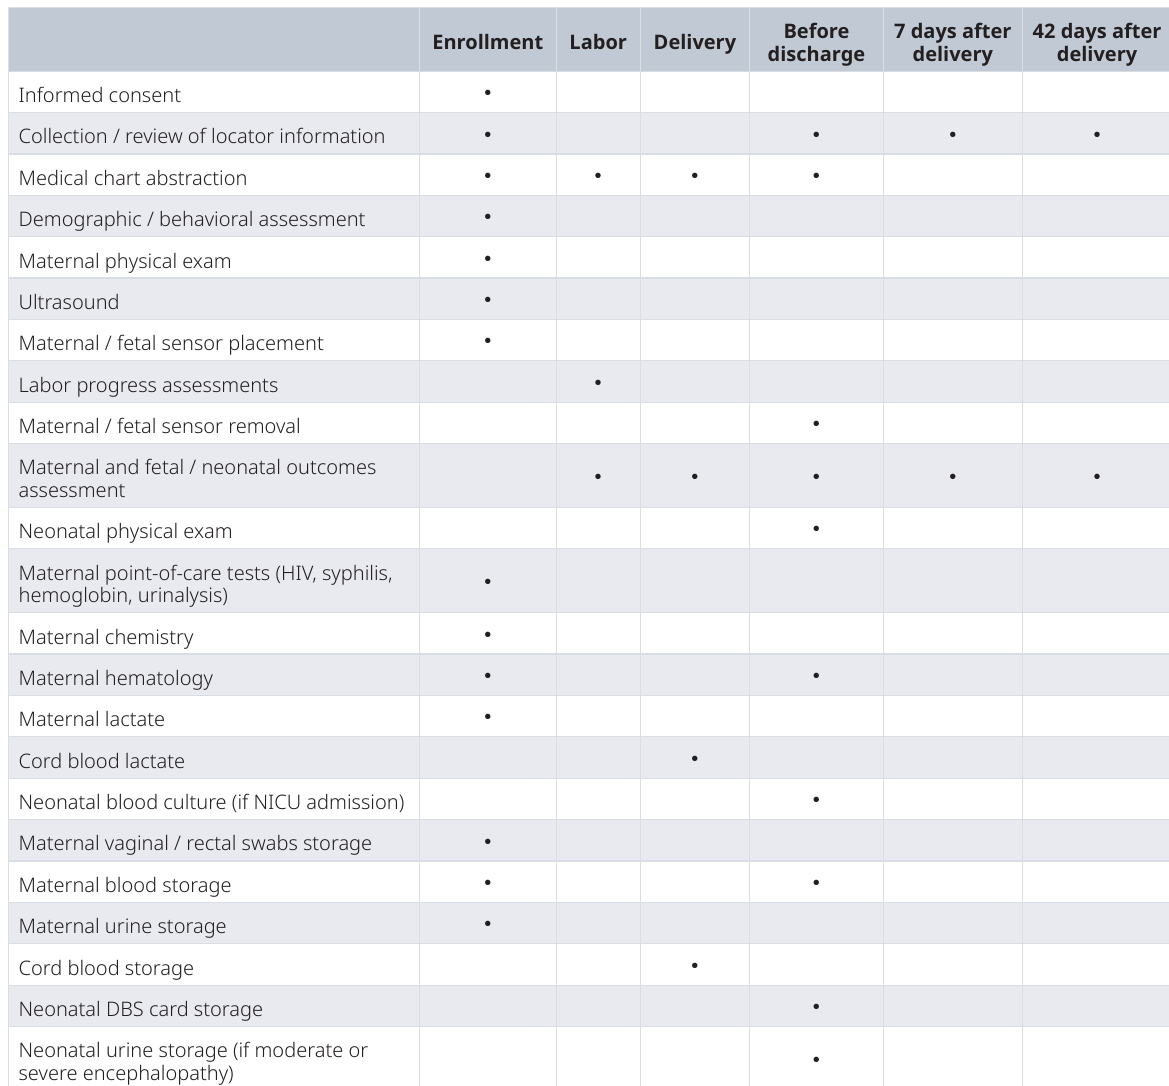
Table 1. Schedule of